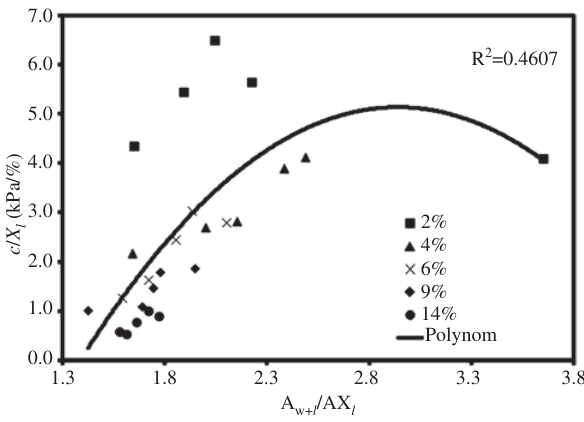
Figure 9 Normalized cohesion versus normalized area ratio (all points).